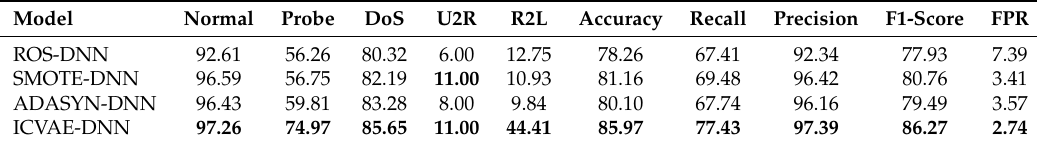
Table 6. Comparison of detection performance for different oversampling methods on the NSL-KDD (KDDTest+) data set (%).